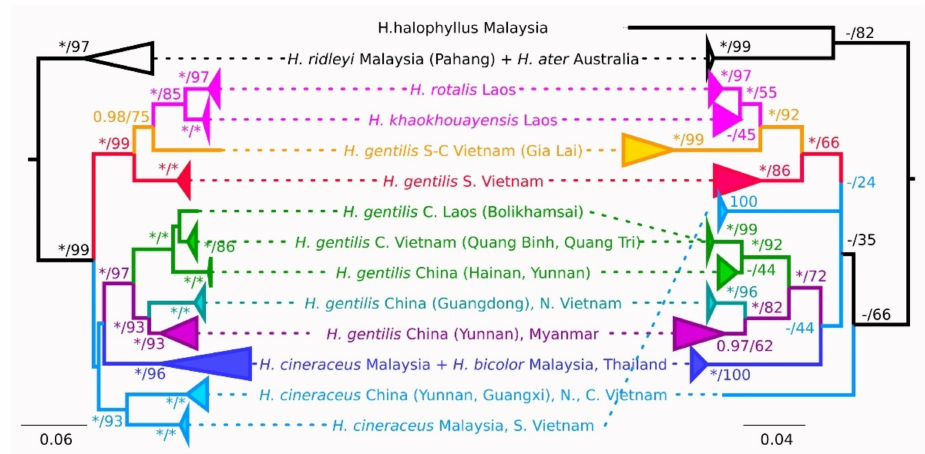
Figure 2. Phylogenetic relationships of selected Hipposideros species inferred from cytb (left) and COI (right) sequences. Topologies for both genes are constructed using maximum likelihood (ML). Bayesian posterior probabilities/maximum likelihood bootstrap supports are shown at the tree nodes. Only bootstrap support values over 70 are shown; maximum supports (Bayesian probability 0.99 and higher, 100% ML) are denoted by asterisks. Dashes denote nodes, which didn’t appear on MB tree. Scale bars indicate genetic distances estimated by the ML method. The bootstrap values are derived from 1000